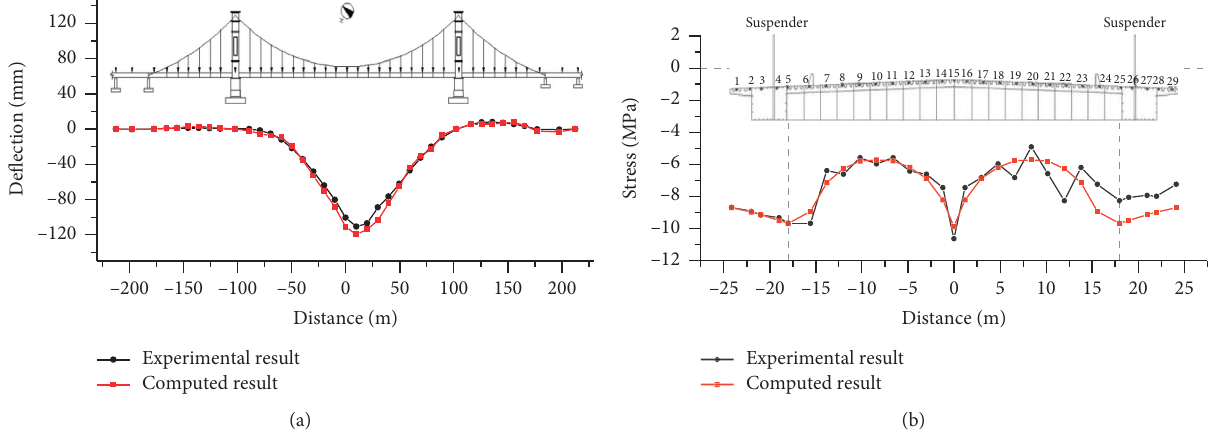
Figure 17: Comparison between experimental result and computed result. (a) Longitudinal distribution of deflection. (b) Longitudinal stress.